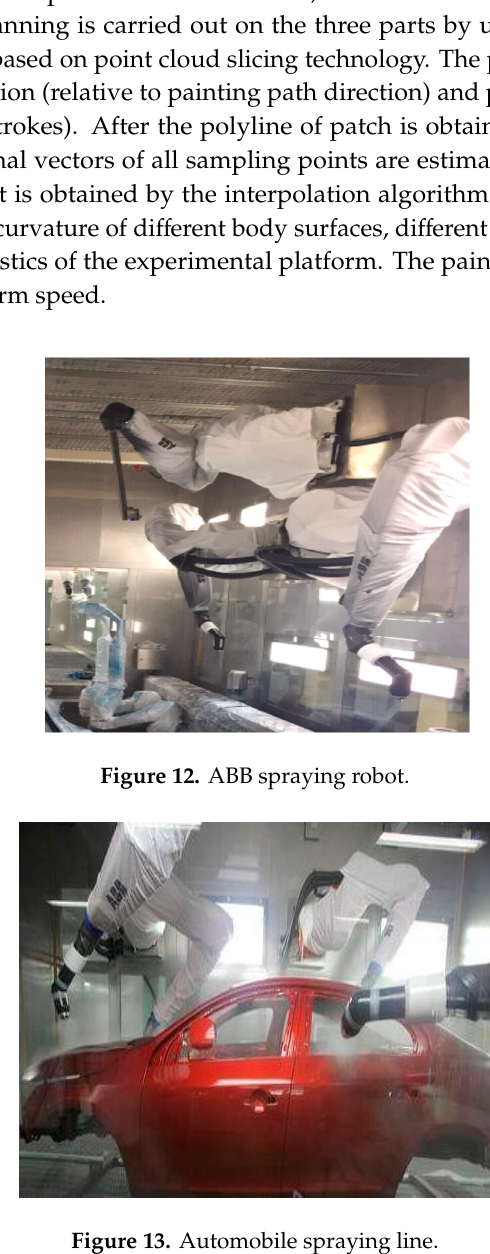
Figure 13. Automobile spraying line.